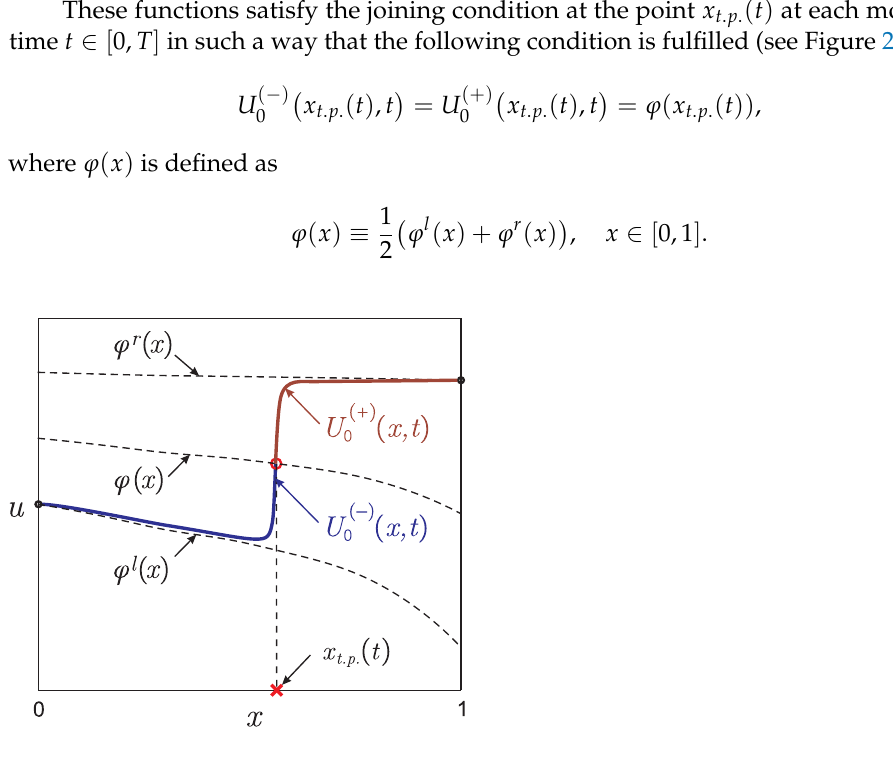
( ∓ ) ( x , t ) and ϕ ( x ) with the localization point of the reaction 0